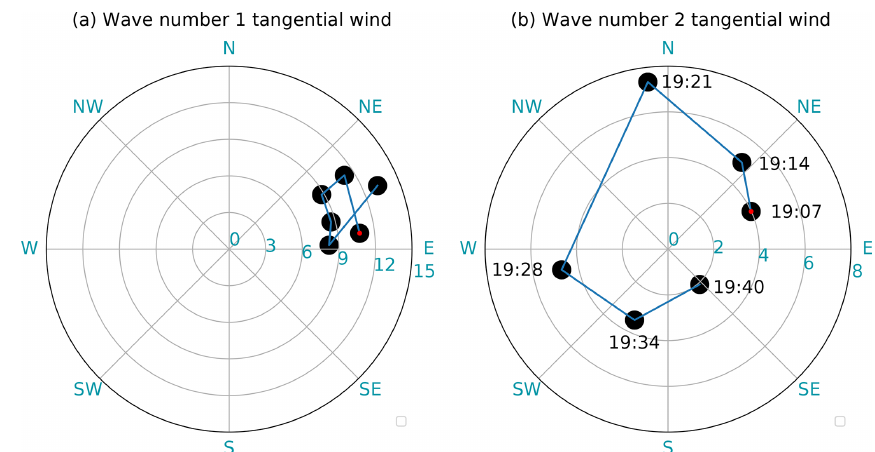
Figure 7. Azimuth and amplitude polar diagram of the temporal evolution of (a) maximum wave number 1 tangential wind amplitude and phase and (b) maximum wave number 2 tangential wind amplitude and phase in the inner eyewall ( < 18km) derived from the GVTD single- Doppler analysis from 19:07 to 19:40UTC on 6 October. The amplitude of the tangential wind component is denoted by the radius of each dot, with the phase denoted by the azimuth. The red dot in panels (a) and (b) indicates the starting time at 19:07UTC, and the temporal evolution follows the blue